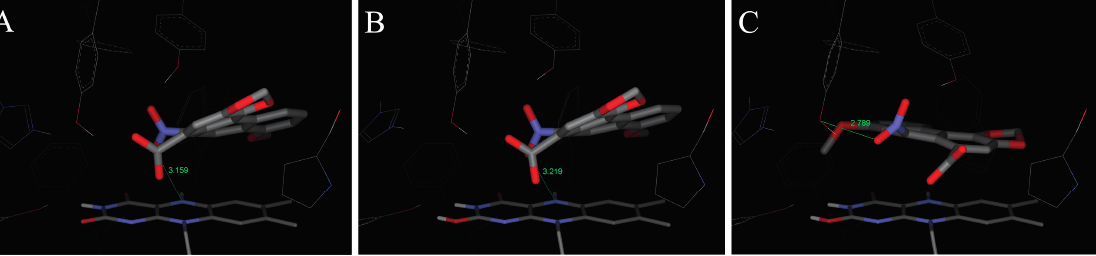
Figure 5. The binding orientations resulting from molecular docking calculations facilitating the hydride transfer from N5 of the isoalloxazine ring of reduced FAD of human NQO1 to the oxygen of AAI. The two possible forms of the reduced isoalloxazine ring (ionized enolate and protonated enol) bound to the NQO1 active site are labeled ( A ) and ( B ), respectively. Binding orientations favoring a proposed alternative three-step (e − , H + , e − ) reduction is labeled as ( C ). AAI and its derivative, FAD cofactor and amino acids residues within 5.5 Å from ligand are rendered as bold sticks, and sticks and lines, respectively